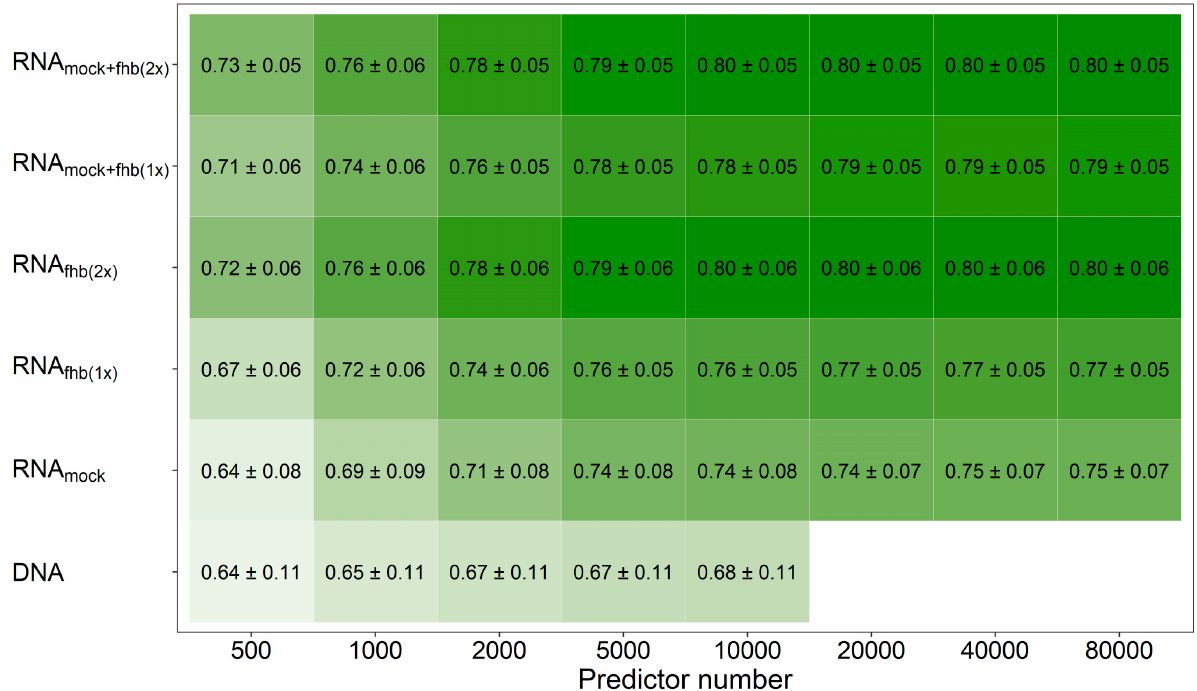
Figure 1. Prediction ability for FHB resistance, anther retention, plant height, and anthesis date 304 using different predictor sets for a genomic prediction with 10,084 SNP markers (DNA) or 90,093 305 expressed genes (RNA). The usage of individual feature matrices of the transcriptomic data ob- 306 tained from mock-treated plants (RNA mock ) or Fusarium -treated plants (RNA fhb(1x) ) was compared 307 with a combination from both Fusarium -treated replications (RNA fhb(2x) ) or from one mock-treated 308 and one Fusarium -treated replicate at time (RNA mock+fhb(1x) ) as well as the integration of gene ex- 309 pression data from all treatment-by-replication combinations (RNA mock+fhb(2x) ). Darker coloring in- 310 dicates a higher average prediction ability.